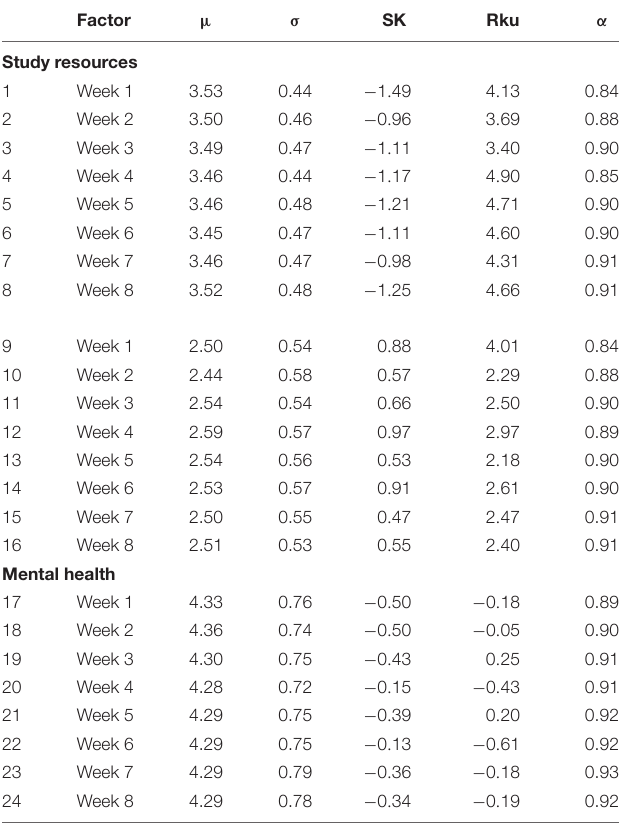
TABLE 3 | Descriptive statistics and Cronbach’s alphas ( n =